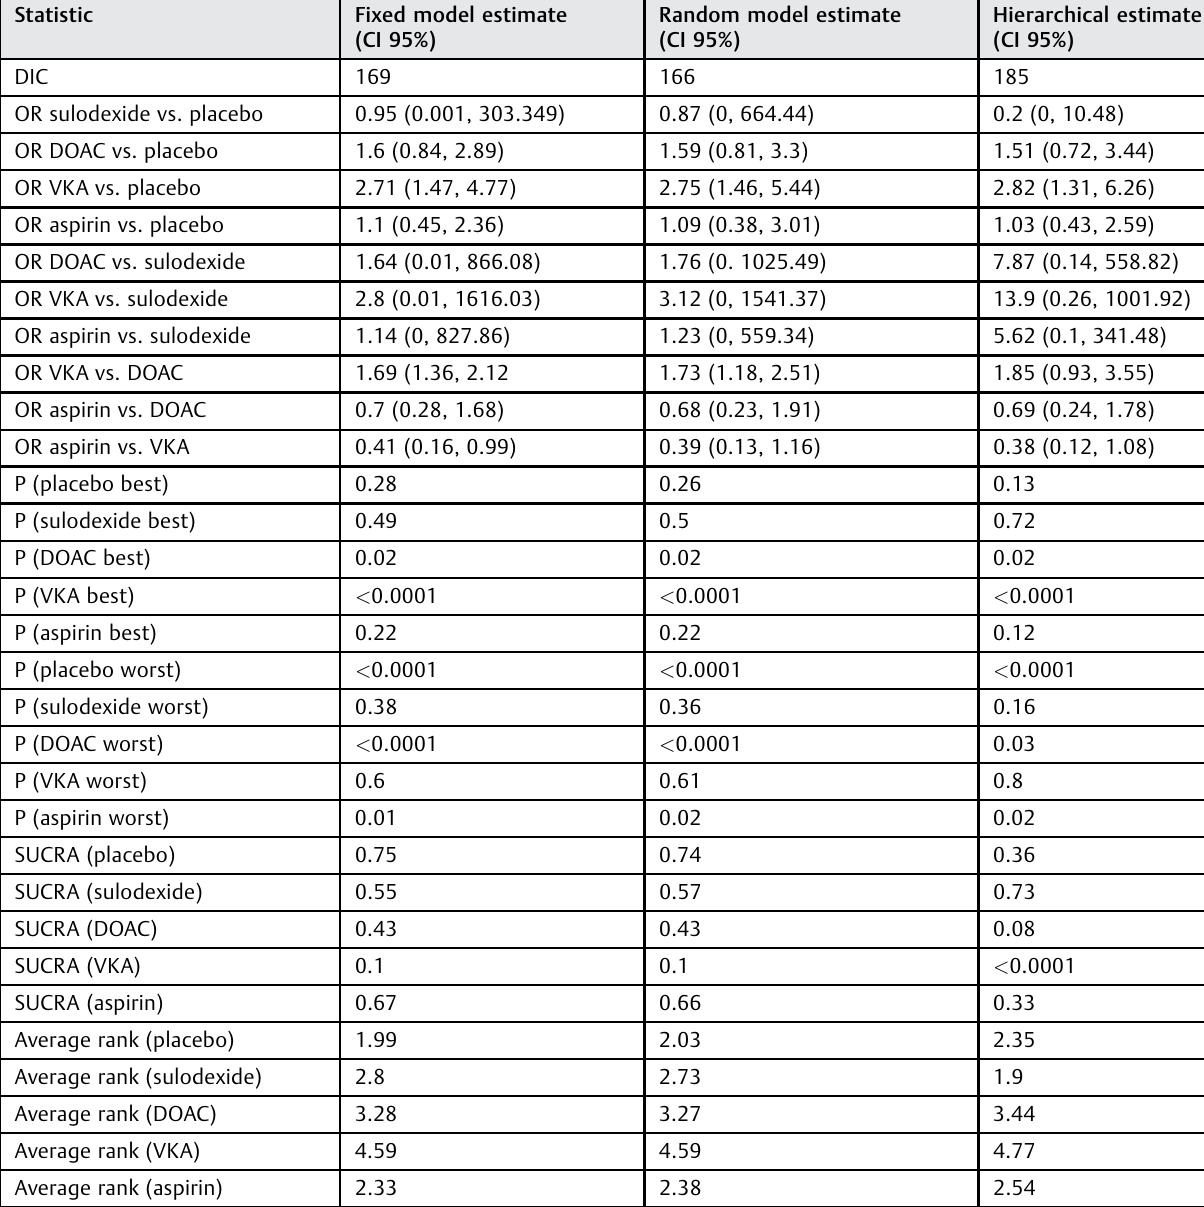
Table 3 Main results for major bleeding, all